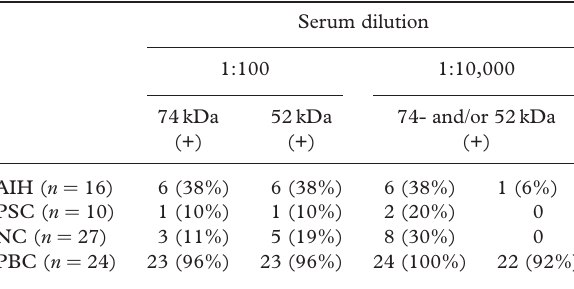
Table II. Serial dilution analysis of PBC and non-PBC sera at IB for anti-PDC-E2 reactivity against E. coli DH5 alpha